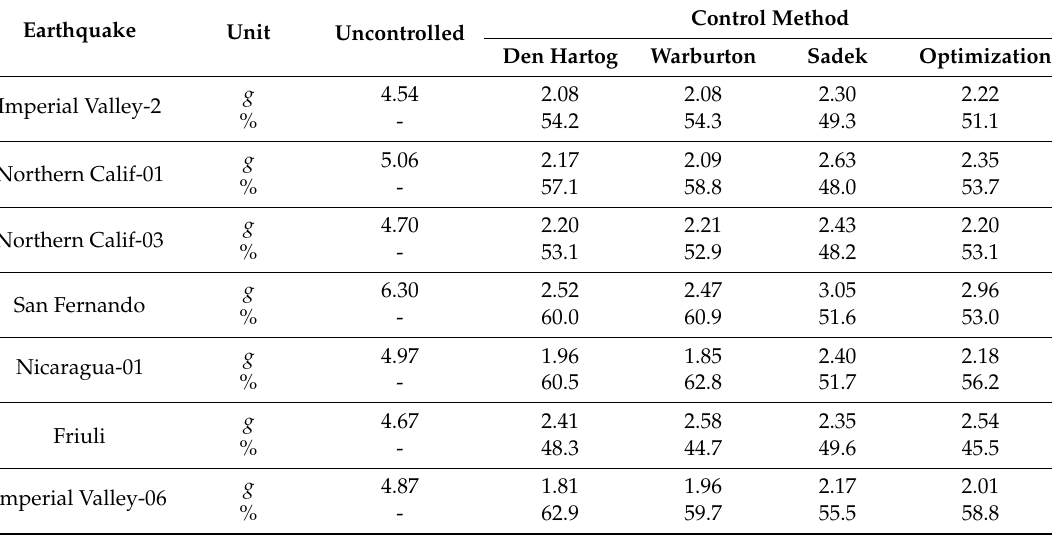
Table 8. Peak spectral acceleration for each